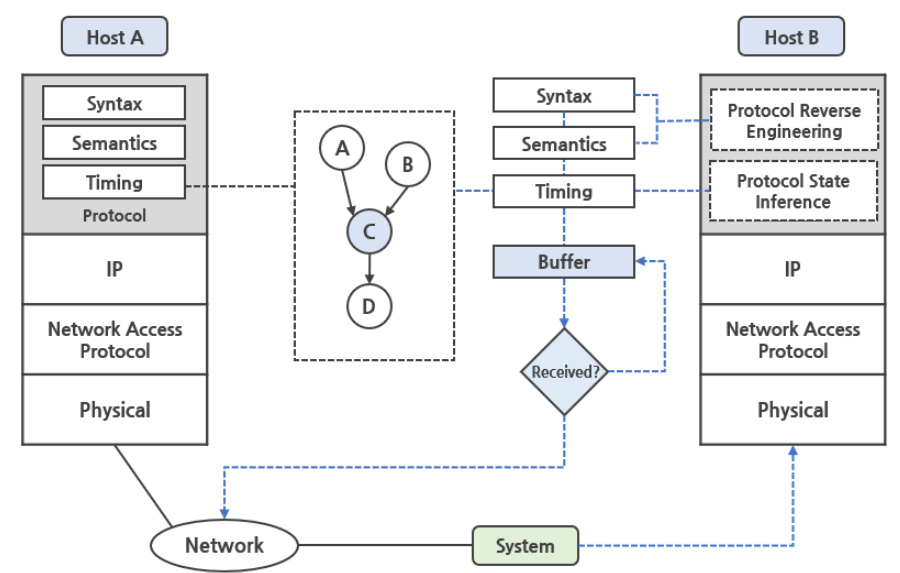
Figure 2. The figure above shows the architecture of the network state inference algorithm through the application of protocol analysis. Through protocol analysis, syntax and semantics of unknown protocol are found, and through this, important state infor- mation for network management is obtained [39].